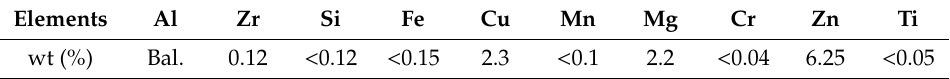
Table 1. Nominal chemical composition of the AA7050 alloy (wt %).